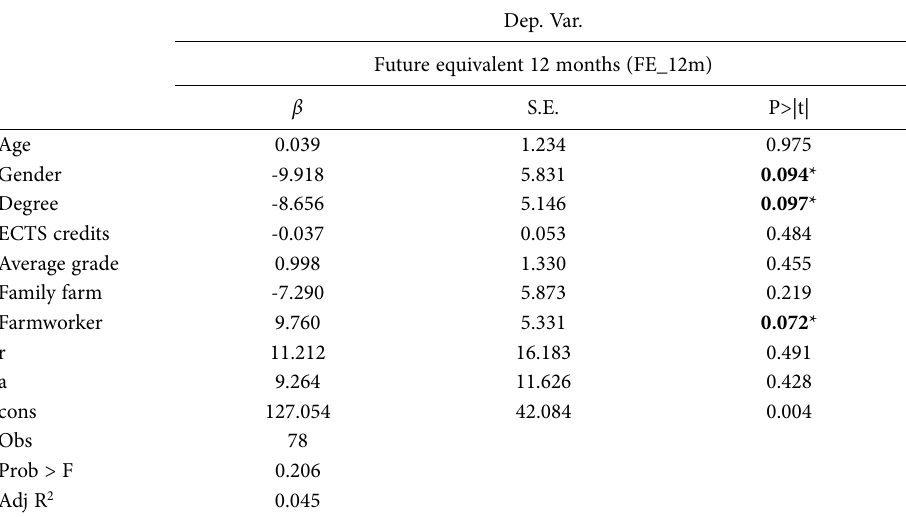
Table 4. OLS - Impatience (FE_12m).